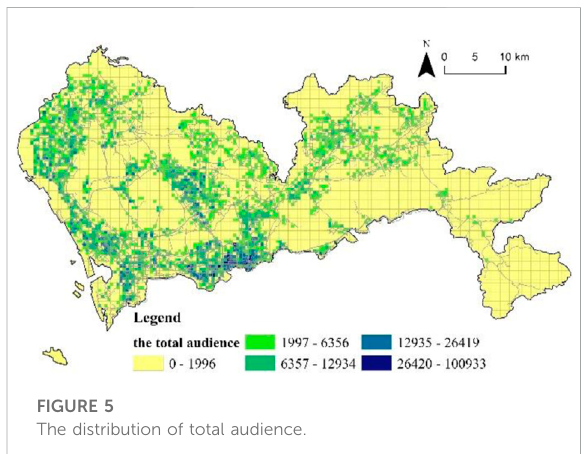
FIGURE 5 The distribution of total audience.